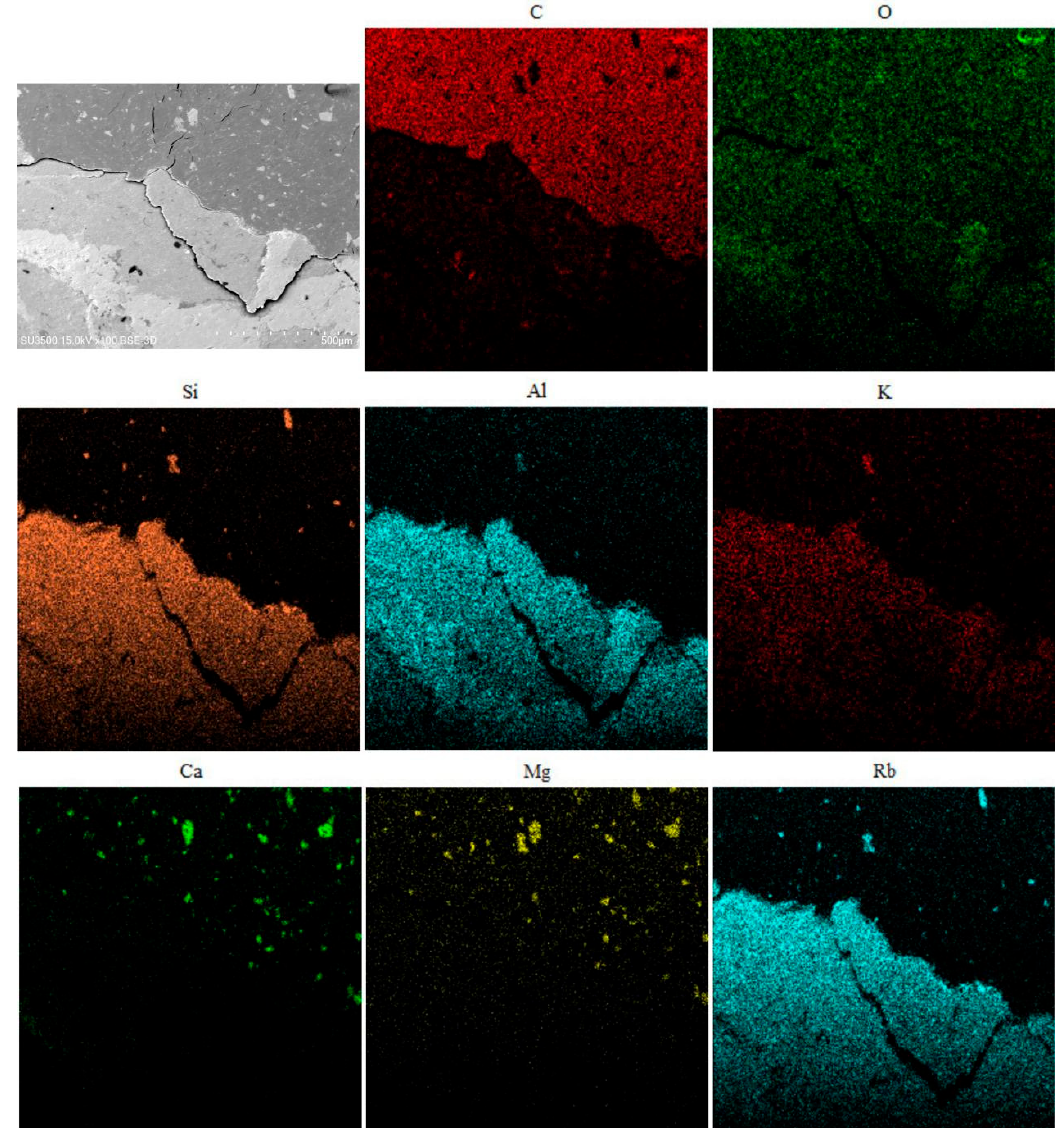
Figure 10. Areal distributions of C, O, Si, Al, K, Ca, Mg, Sn, Rb, CS, and W in sample 12L-2.